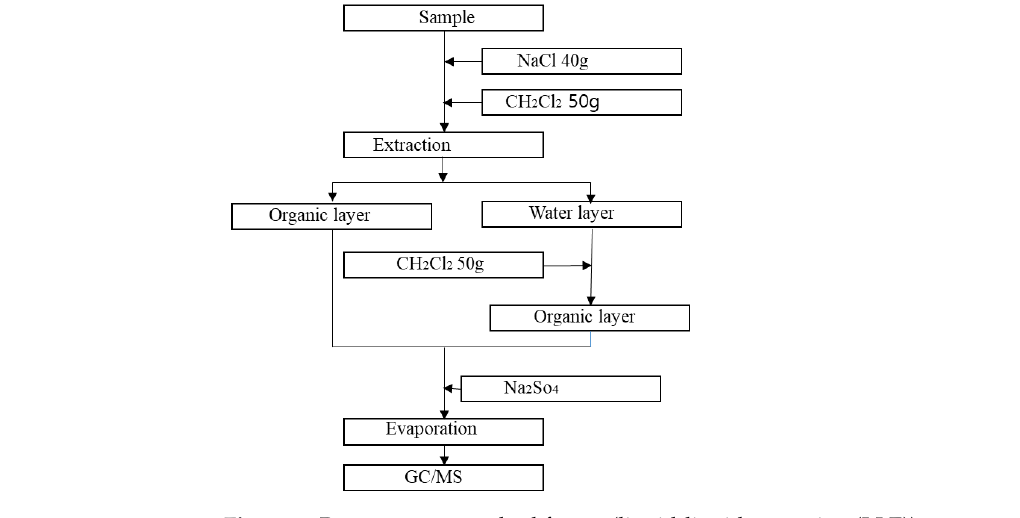
Figure 9. Pre-treatment method for tar (liquid-liquid extraction (LLE)). Table 6. GC/MS analysis conditions for tar generated from biomass gasification plants.